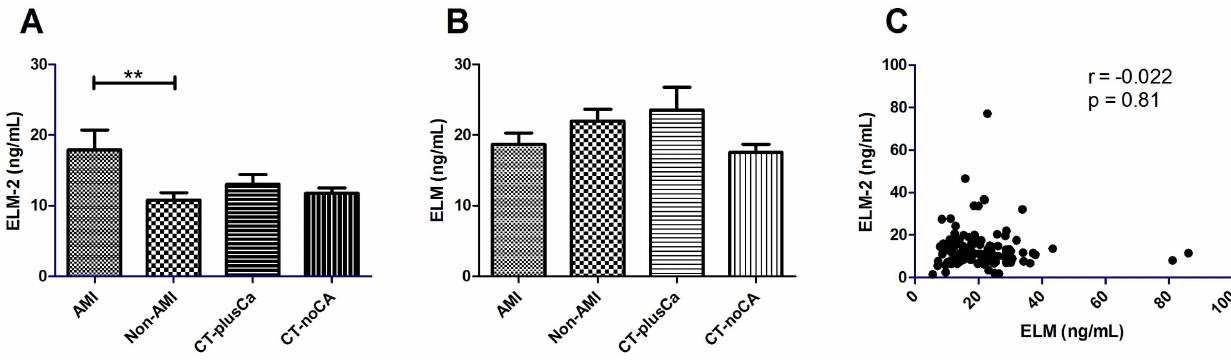
Figure 3. Biological validation of ELM and ELM-2 in the cardiovascular cohort. Human serum from patients with acute myocardial infarction (AMI) (n=30), non-AMI (n=30), coronary calcium shown on CT scans (CT-plusCA)(n=30) and no coronary calcium detectable on a CT scan (n=30). Bars indicate mean level. Groups were compared by Wilcoxon rank sum test. A)ELM-2, B) ELM and C) The Spearman correlation between ELM and ELM-2. Data are shown as mean 6 SD with 95% confidence intervals. ** p , 0.01.